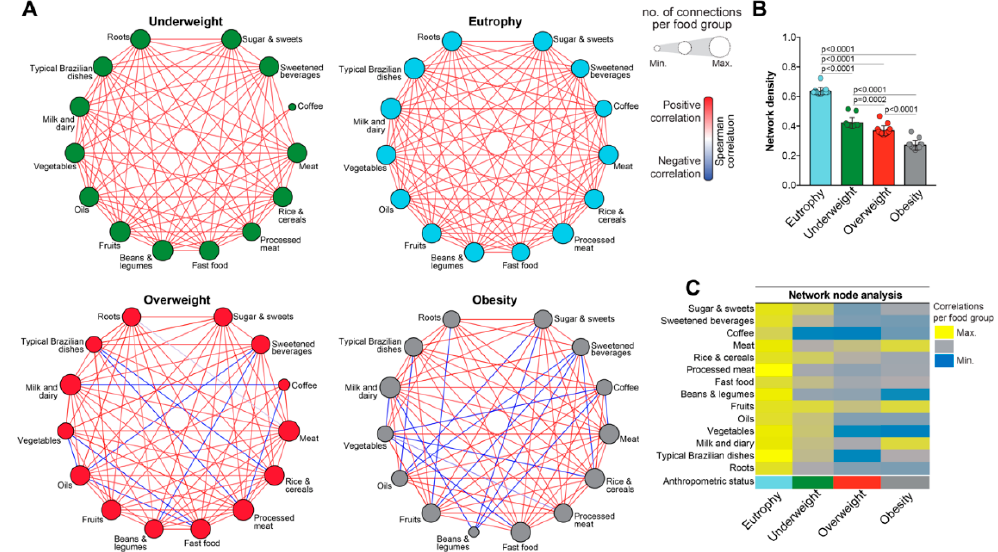
Figure 4. Network analysis of the correlations of consumption of food groups according to the anthropometric status. ( A ) Spearman correlation matrices were constructed for each subgroup of individuals stratified by anthropometric status. The matrices were submitted to 100X bootstrap. Only statistically significant correlations ( p < 0.05 after adjustment for multiple comparisons), with rho (r) values >0.5 and that remained significant in at least 50% of the bootstraps were included in the network analyzes. ( B ) The network density, inferring significant number of correlations, was calculated on each bootstrap and the values were compared between the groups using the Kruskal-Wallis test with Dunn’s multiple comparisons post-test. The p values of the comparisons are shown. ( C ) Node analysis was performed comparing the number of correlations statistically significant for each food group in the different subgroups of individuals.